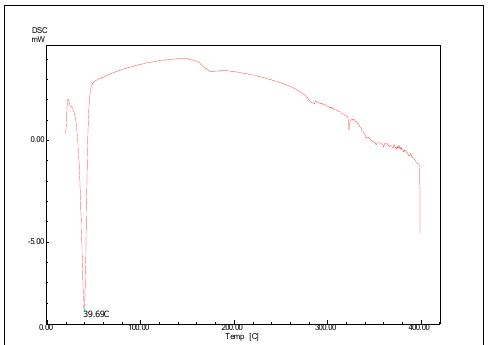
Figure 11. DSC thermogram of TPGS